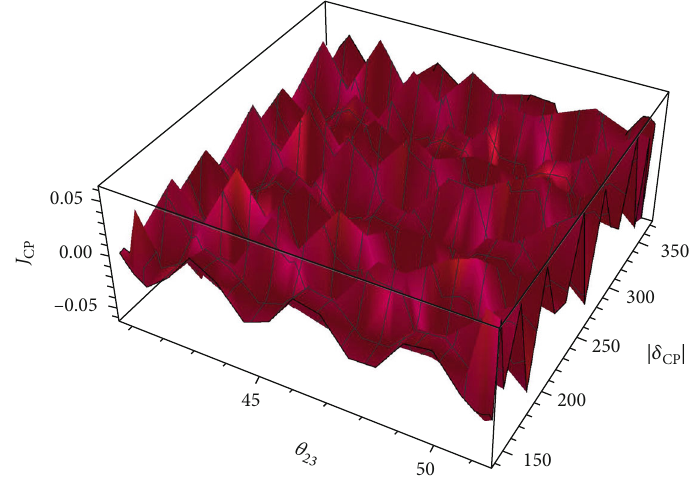
Figure 18: Predictions in the broken μ − τ symmetry model for inverted ordering: predicted allowed three-dimensional space of the ð delt Þ plane for allowed regions of Jarkslog invariant, J a , θ , J CP 23 CP contribution of the type I seesaw mechanism to neutrino mass